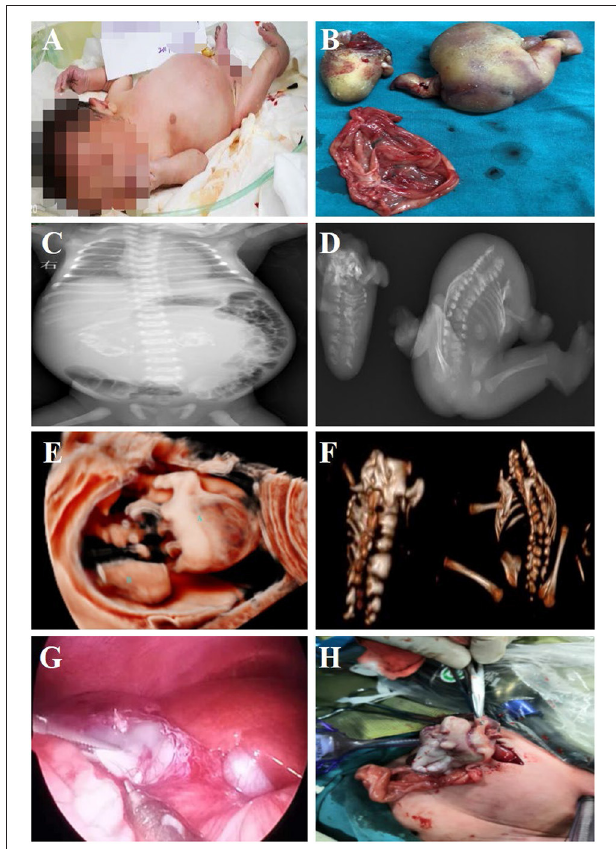
FIGURE 2 | Fetus-in-fetu. (A) Patients with abdominal FIF present with abdominal bulging; (B) Specimen manifestations after FIF resection of the abdominal cavity; (C) Radiographic examination showed a bone-like shadow in the abdominal cavity; (D) Radiographic examination of FIF after operation; (E) Three-dimensional ultrasonic testing for FIF; (F) CT three-dimensional reconstruction technology to detect FIF after excision of the FIF; (G,H) The characteristics of FIF under laparoscopy, and it was extracted by enlarging umbilical